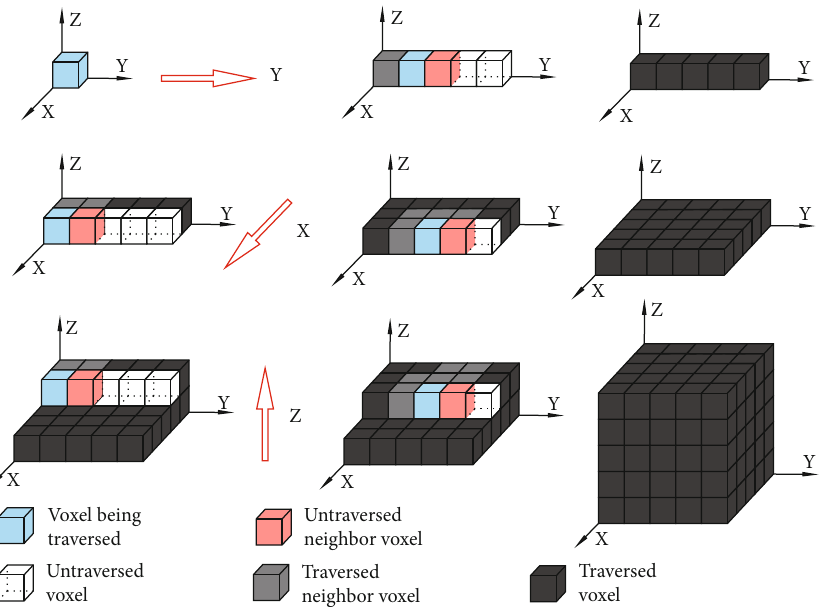
Figure 1: Reconstruction of digital core based on the MCMC method